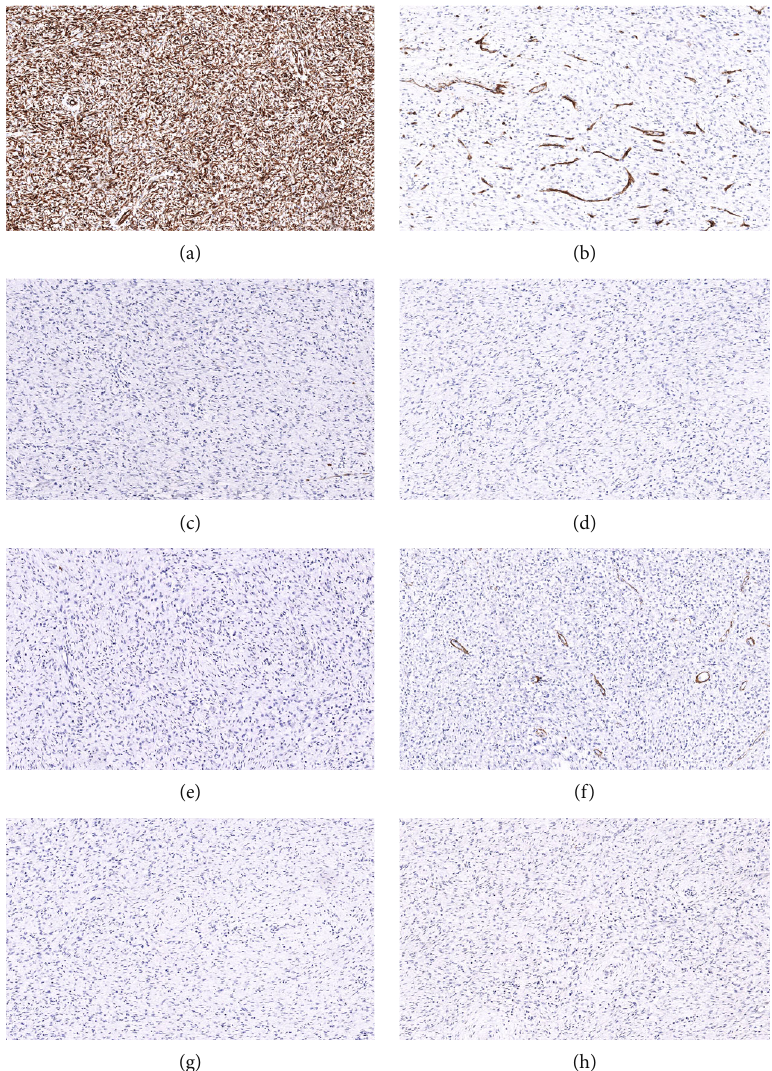
Figure 2: Immunohistochemical staining showed that the spindle-shaped mesenchymal cells were positive for vimentin (a) and negative for CD34 (b), CD117 (c), DOG1 (d), S-100 (e), SMA (f), STAT6 (g), and ALK (D5F3) (h) (original magni fi cation: ×